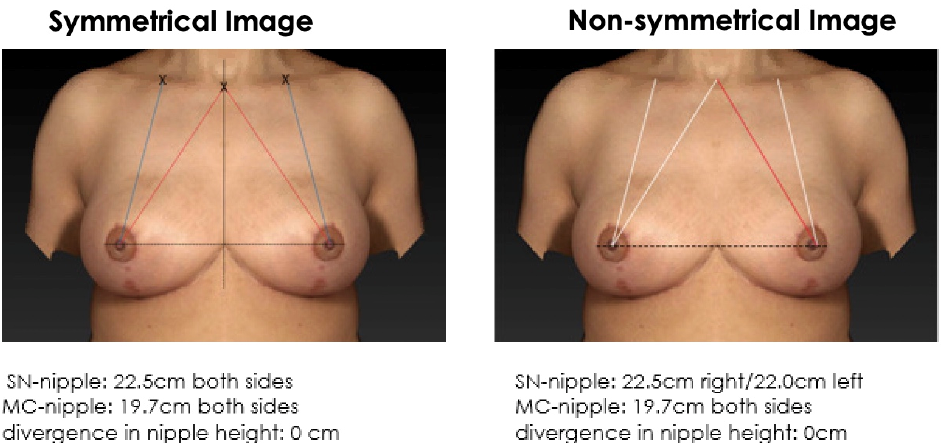
Figure 2. The professional spectrum of the participants in the departments in German-speaking countries.